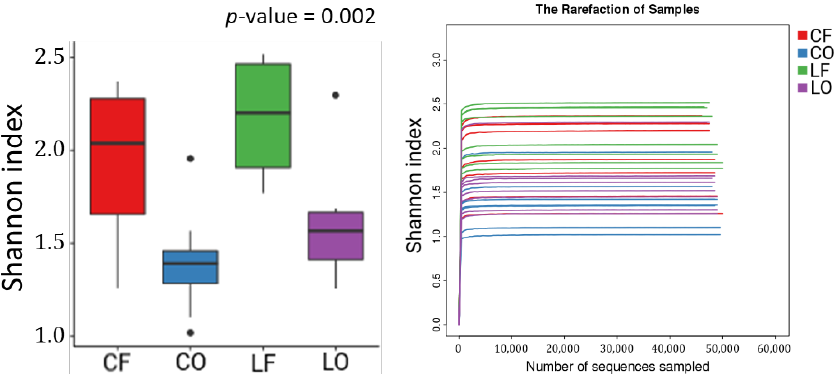
Figure 5. ( A ) Species diversity depicted by an Operational taxonomic units (OTU) rank curve; ( B ) Rarefaction curves and alpha diversity indices, comparing community richness (sobs) and diversity (Shannon) between hamsters fed one of the four diets: CF, fresh corn oil; CO, oxidized corn oil; LF, fresh lard; LO, oxidized lard.